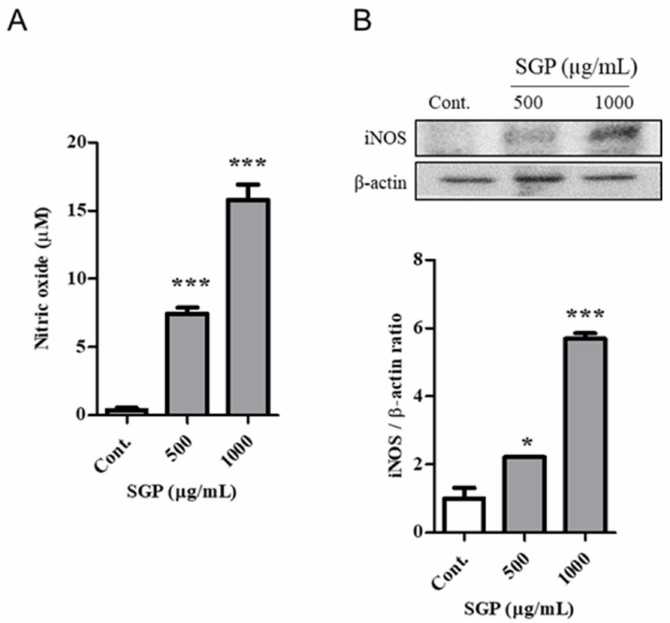
Figure 4. Effects of SGP on NO and iNOS levels in RAW264.7 macrophages. RAW264.7 macrophages were inserted into 500 and 1000 µ g/mL SGP for 22 h (for NO) or 18 h (for iNOS). After 22 h, cell supernatants were used for NO production analysis. Supernatants were used according to the Griess method ( A ). After 18 h, cells were collected to evaluate iNOS protein levels; expression levels were determined through immunoblotting and quantification of iNOS/ β -actin intensity ( B ). Shown are the means ± SD of triplicate experiments. * p < 0.05 and *** p < 0.0001, compared to the controls. 3.5. SGP Increased Immune-Enhancing Activity through Phosphorylation of MAPKs and NF- κ B Signaling Pathways in RAW264.7